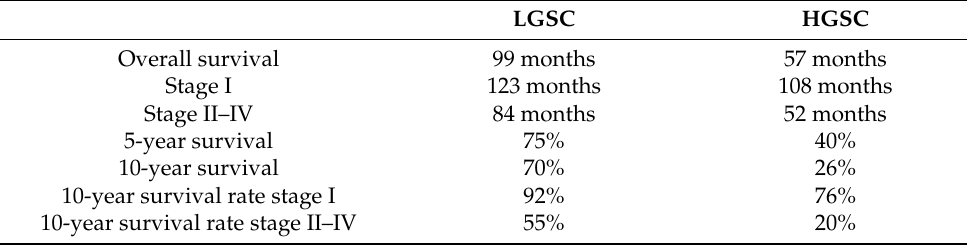
Table 1. Survival rate for LGSC compared to HGSC [5]. LGSC HGSC Overall survival 99 months 57 months Stage I 123 months 108 months Stage II–IV 84 months 52 months 5-year survival 75% 40% 10-year survival 70% 26% 10-year survival rate stage I